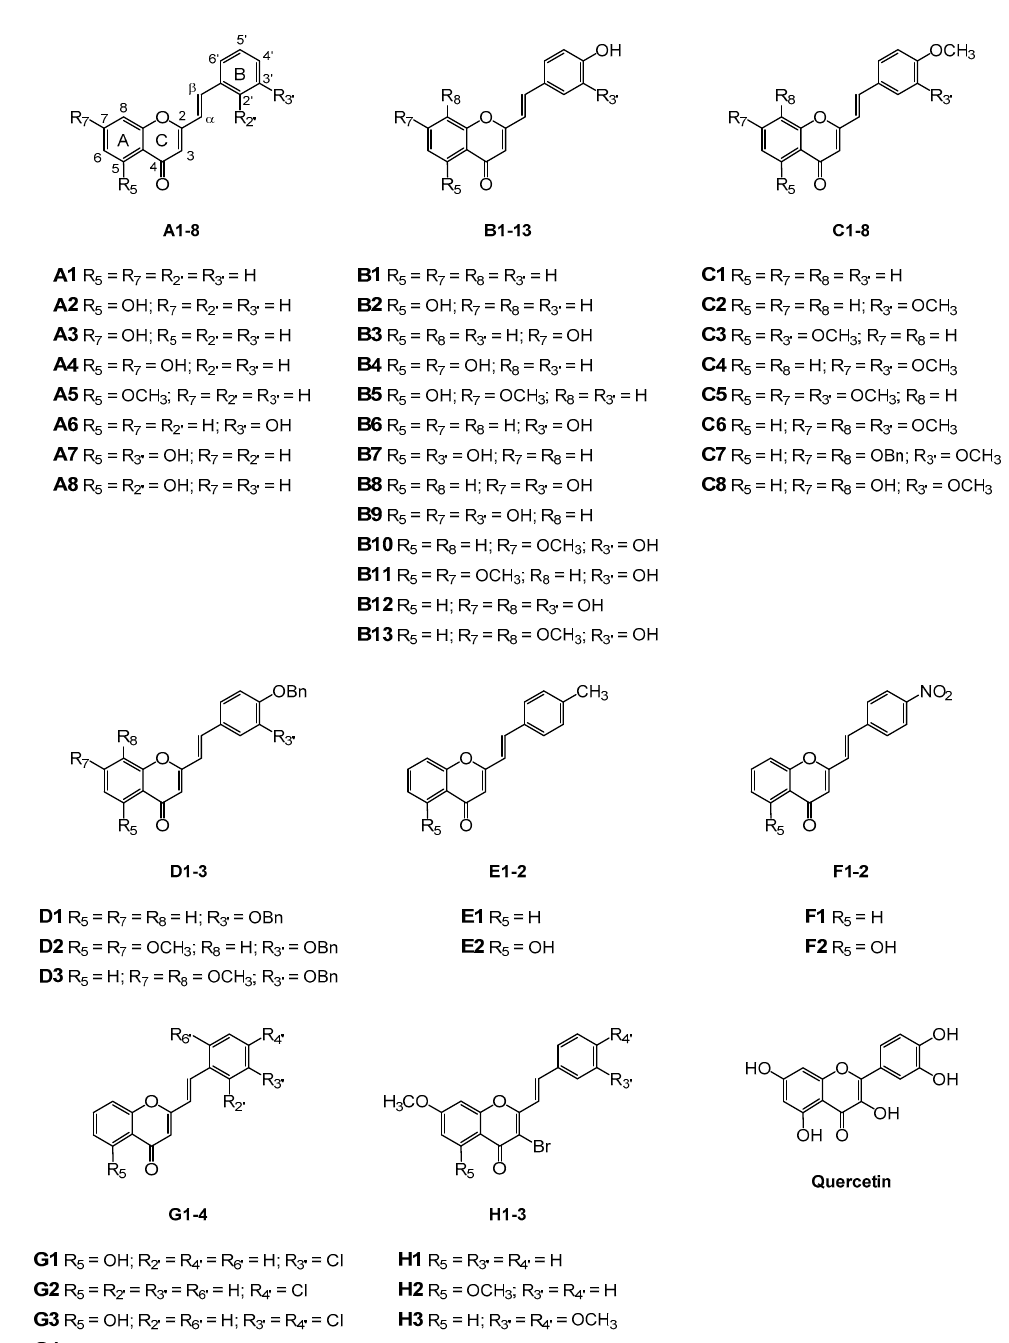
Figure 3. Chemical structures of the studied 2-SC and of the positive control, quercetin. 2-SC